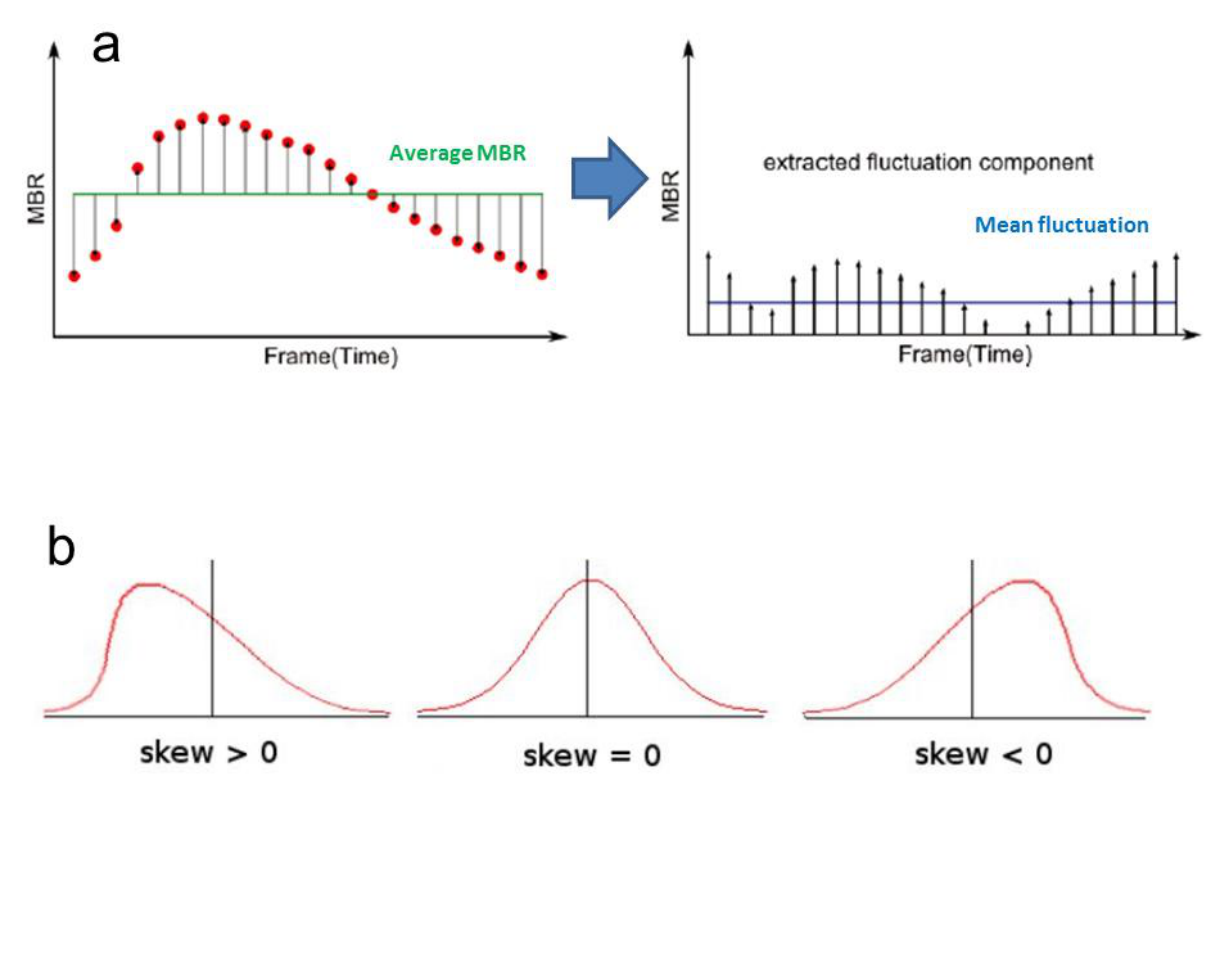
Figure 6. Schematic explanations of the parameters obtained from waveform analysis: ( a ) fluctuation, ( b ) skew, ( c ) blowout score (BOS), ( d ) blowout time (BOT), ( e ) rising rate, ( f ) falling rate, ( g ) flow acceleration index (FAI), ( h ) acceleration time index (ATI), and ( i ) resistivity index